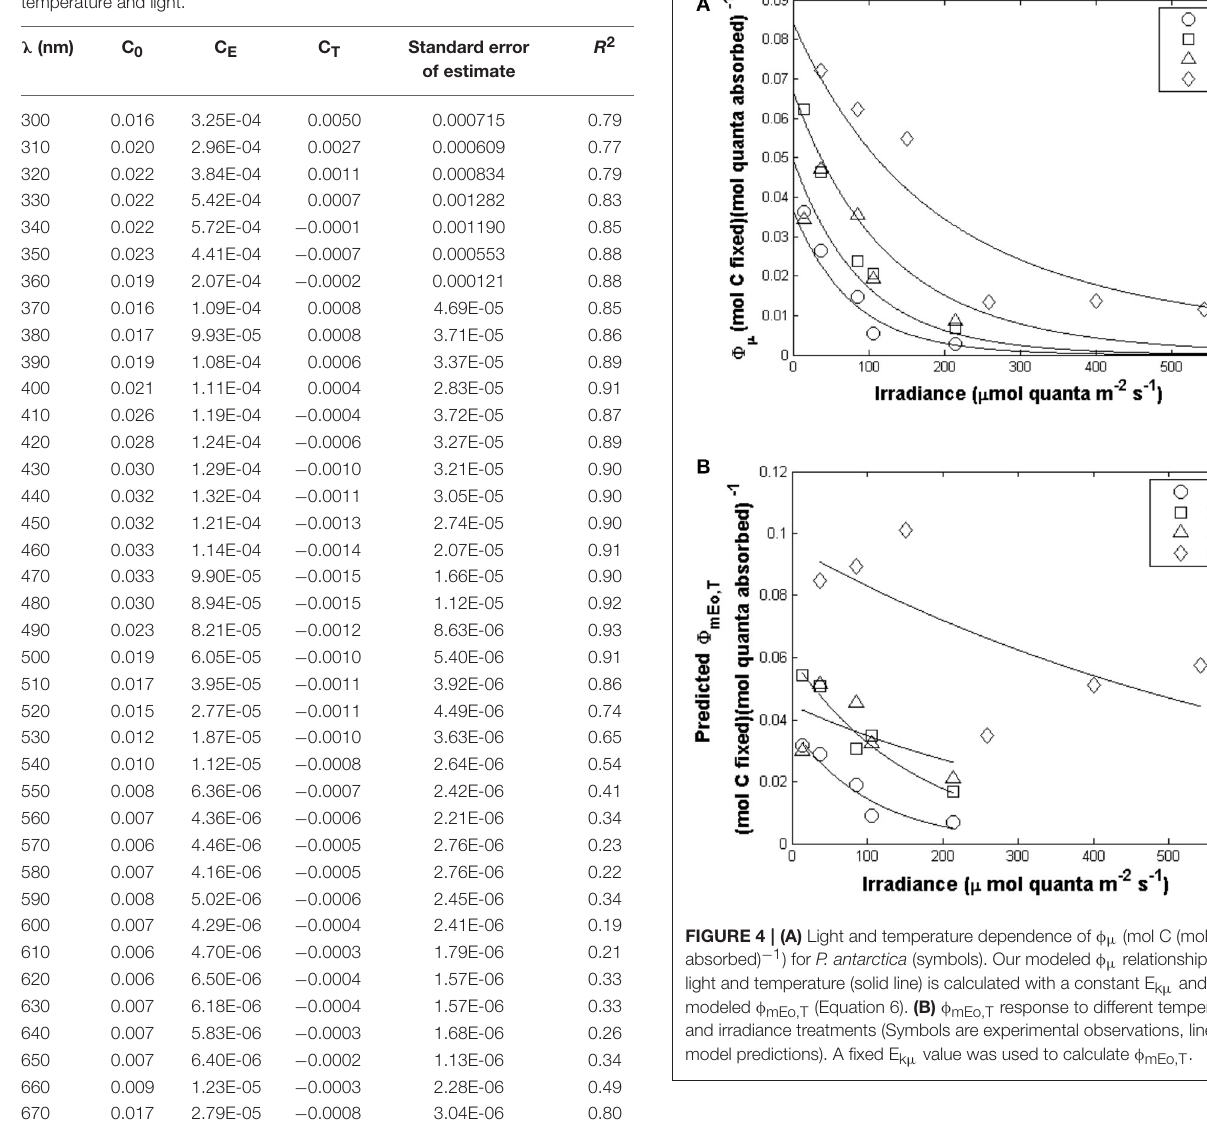
TABLE 4 | Coefficients for multiple-linear regression model for a* ph ( λ ) based on temperature and light.